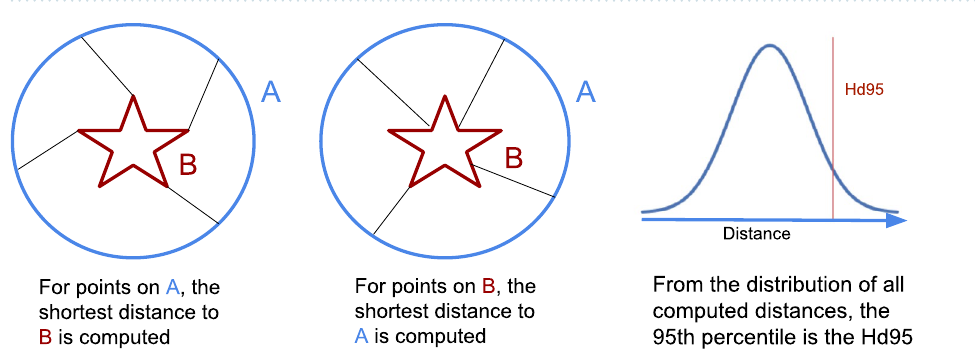
Figure 2. An illustration of how the Hausdorff 95% distance (Hd95) is computed between two example